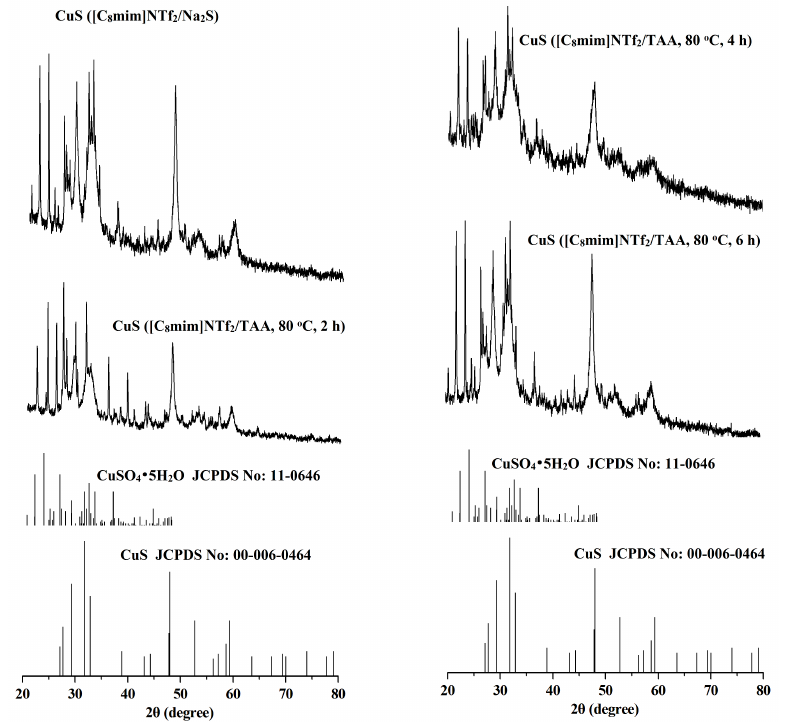
Figure 1. X-ray diffraction (XRD) patterns of the copper sulfide (CuS) prepared in the Figure 1. X-ray di ff raction (XRD) patterns of the copper sulfide (CuS) prepared in the [C 8 mim]NTf 2 /water systems. [C 8 mim]NTf 2 / water